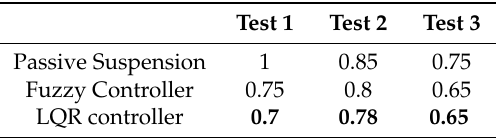
Table 1. Maximum load transfer coefficient,